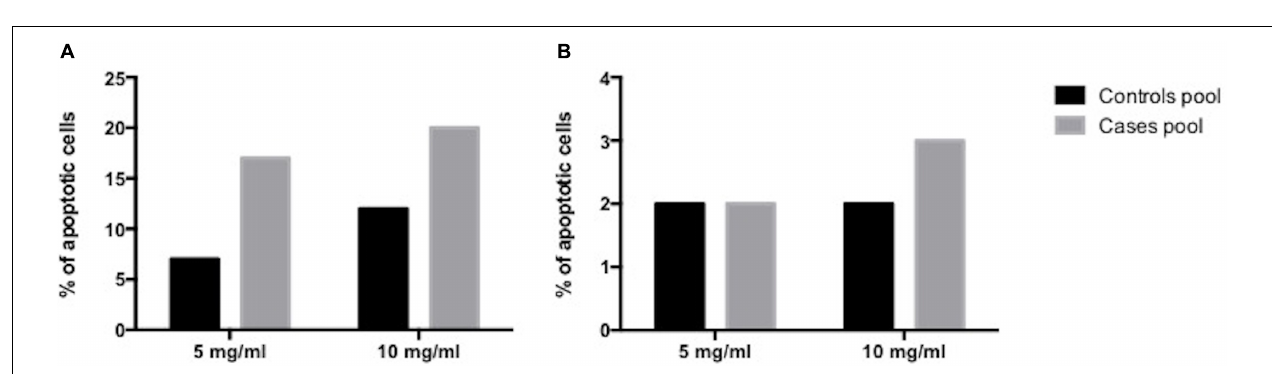
FIGURE 3 | Human placenta-derived VE apoptosis induction analysis. (A) at 8 h (B) at 24